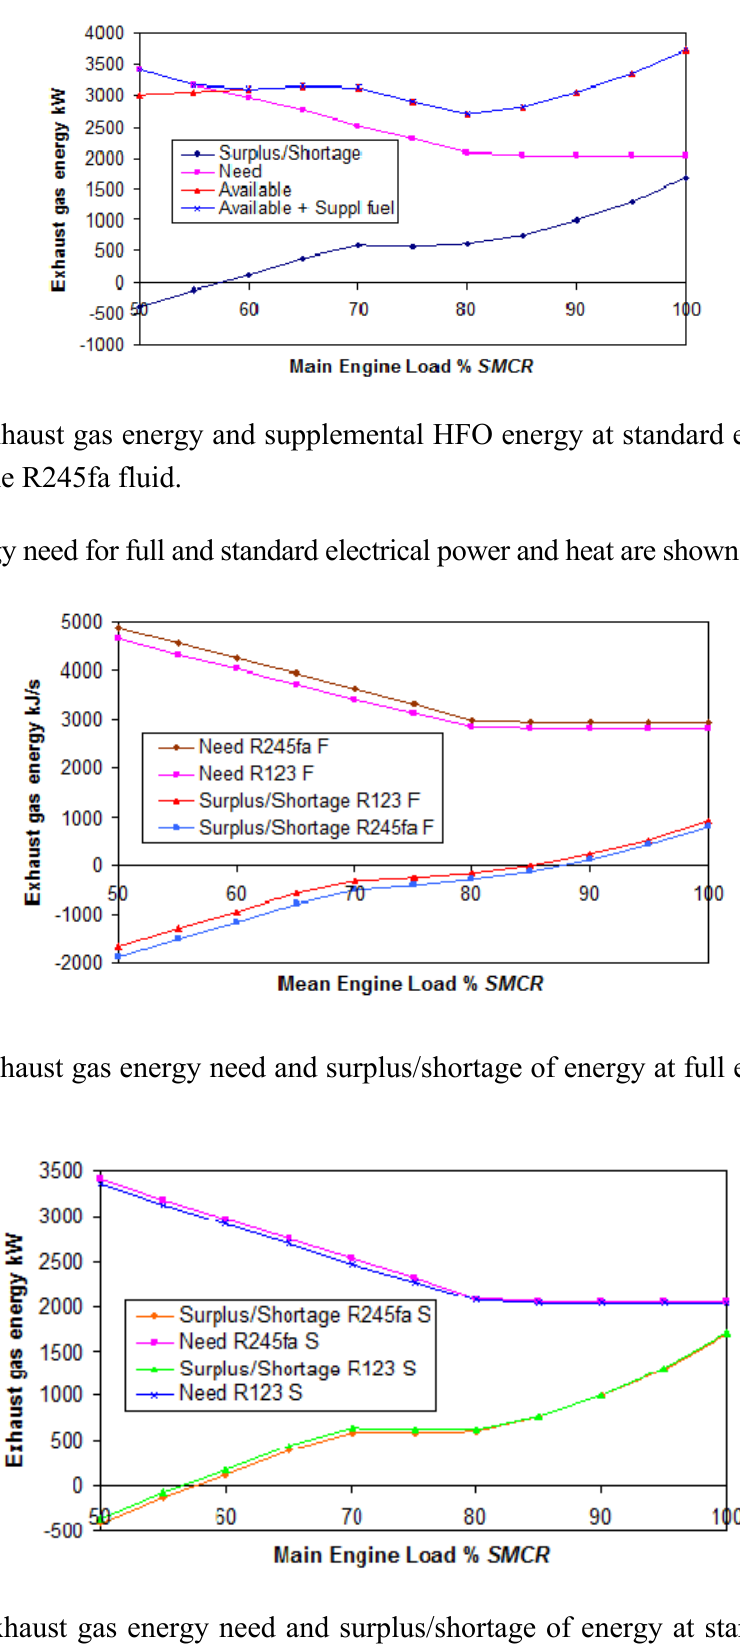
Figure 13. Exhaust gas energy need and surplus/shortage of energy at standard electrical power and